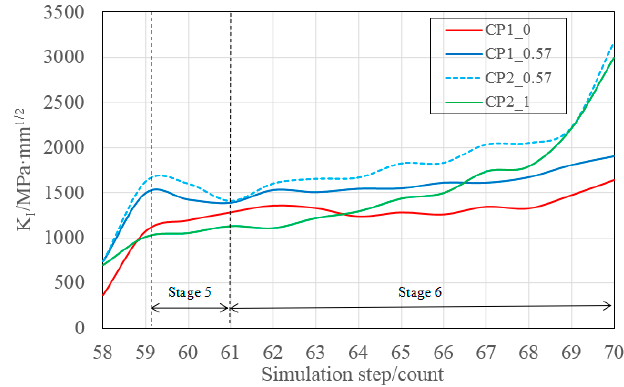
+ SERR, stage 5 and